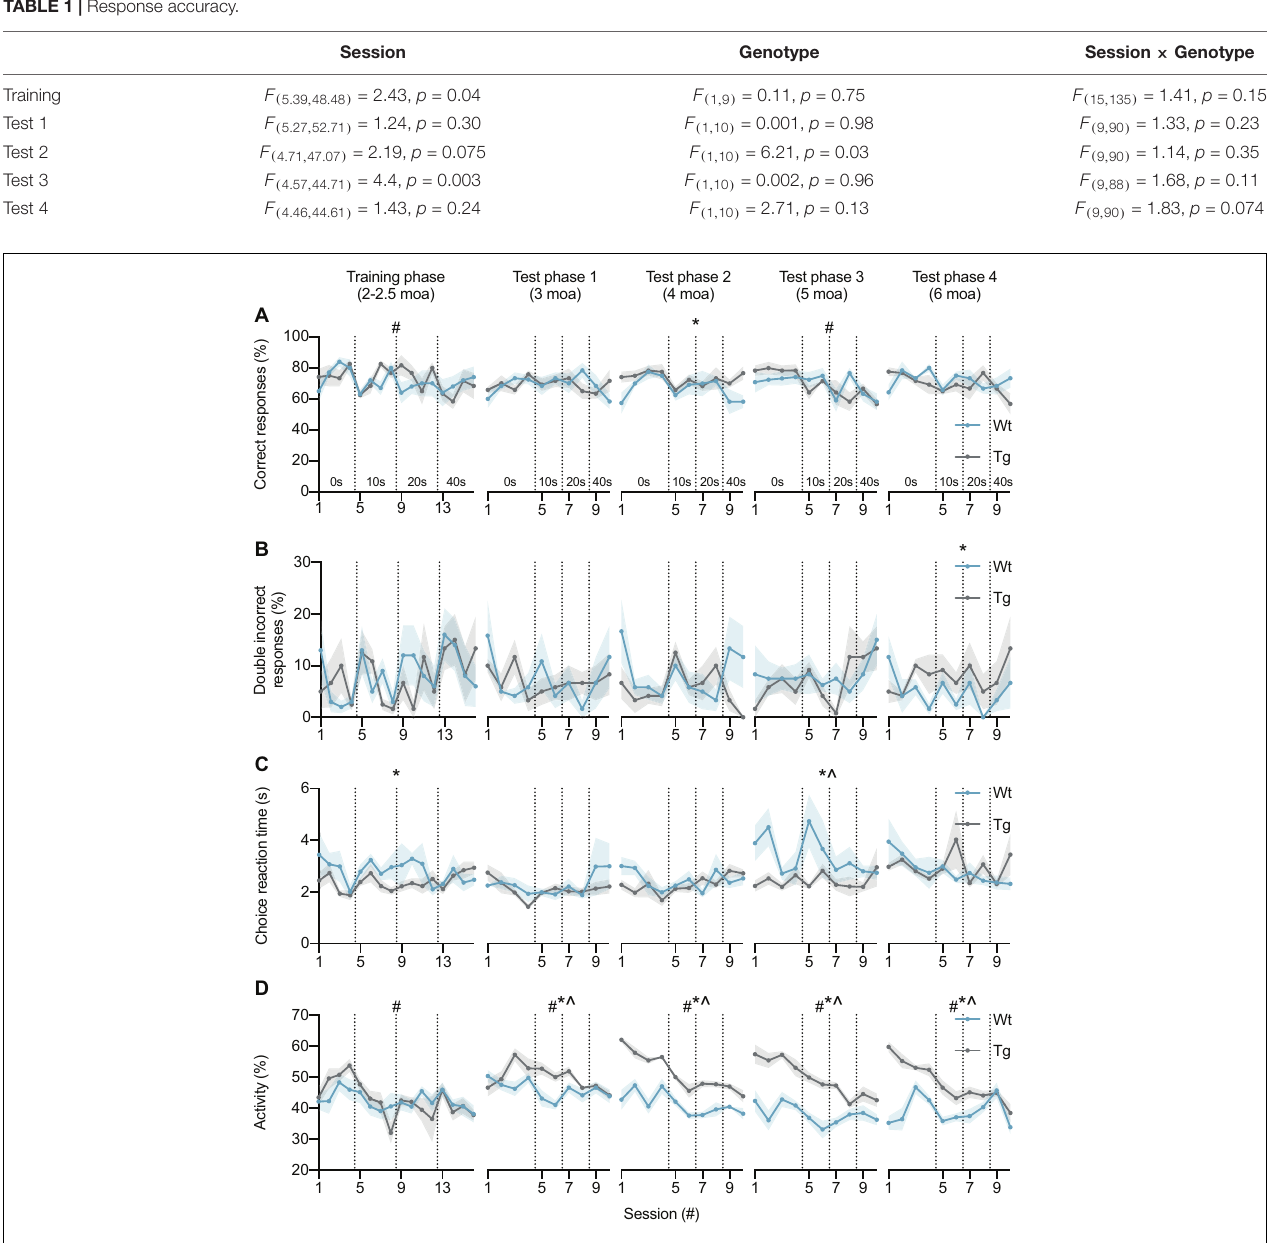
FIGURE 3 | DAT performance of wild-type and APP/PS1 mice at 2–2.5, 3, 4, 5, and 6 moa. (A) Response accuracy of wild-type ( n = 6, blue) and APP/PS1 ( n = 6, gray) mice during training and test phases. During the training phase, two-way ANOVA showed an effect of session (#), with significant differences between sessions 3–5, 4–5, and 5–8. In test phase 2, a main effect of genotype (*) was observed. Analysis of test phase 3 showed a main effect of session, with significant differences between sessions 4–9 and 6–10. (B) APP/PS1 mice showed an increase in the percentage of consecutive incorrect responses in test phase 4 at 6 moa. (C) Choice reaction time of APP/PS1 mice was significantly lower compared to wild-type controls in the training phase and test phase 3. (D) At 3, 4, 5, and 6 moa, APP/PS1 mice were more active than wild-type mice. Vertical lines indicate the start of a new delay interval. #main effect of session, p < 0.05; *main effect of genotype p < 0.05; ˆinteraction effect p <